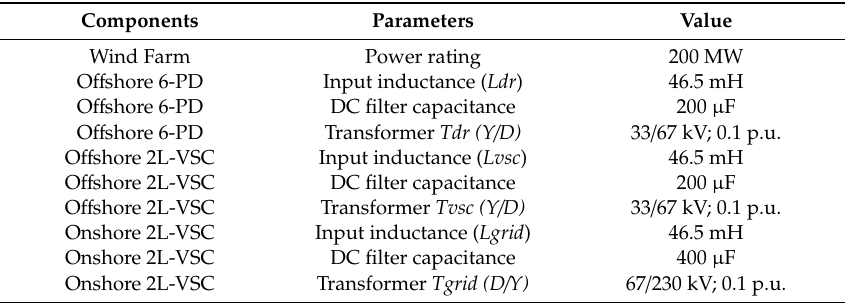
Table 1. Parameter of the hybrid HVDC system.